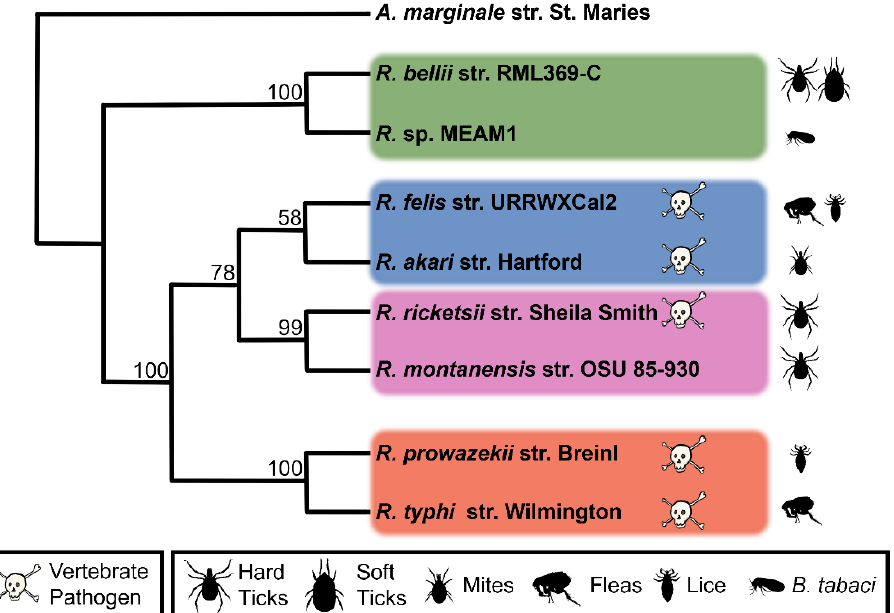
Figure 1. Maximum likelihood phylogenetic tree of the eight species of Rickettsia used in this study. Rickettsia groups are demarcated by colored rectangles and vertebrate pathogens are marked with a skull and crossbones. Bootstrap values are given at corresponding nodes. Anaplasma marginale is used as an outgroup to root the tree. Silhouettes represent known arthropod hosts.